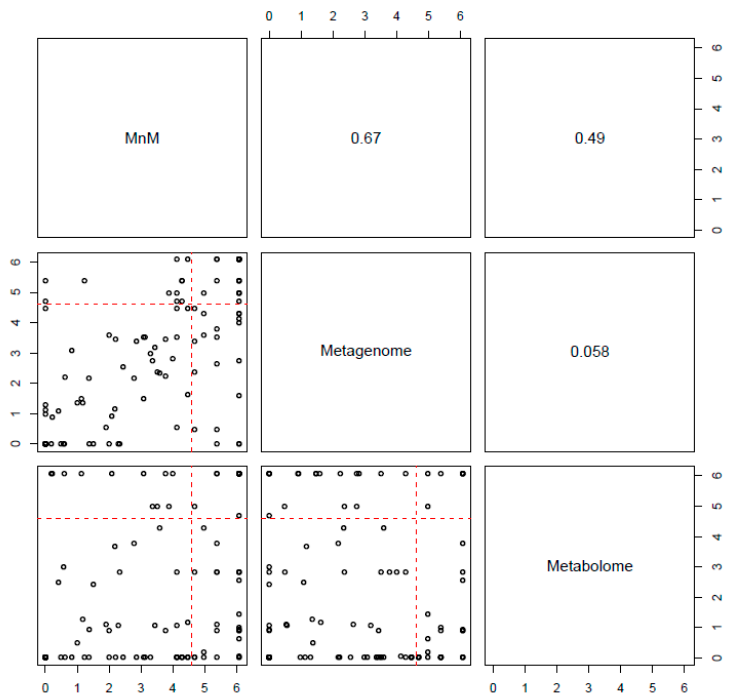
Figure 2. Pairwise scatter plot of 111 pathways’ p -values calculated by each method. The upper panel shows the Spearman’s rank correlation coefficient, and the lower panel is a scatter plot of the 111 pathways’ p -values. These p -values, from each method, were adjusted by Bonferroni correction, and a cutoff of 0.01 is represented by the red dotted lines.